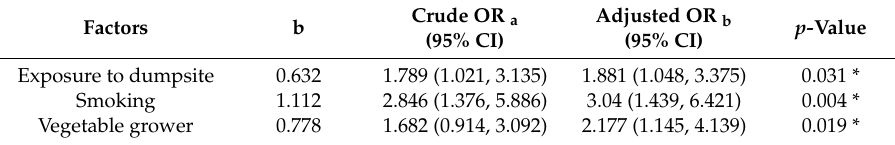
Table 3. The association between dumpsite exposure and sore throat